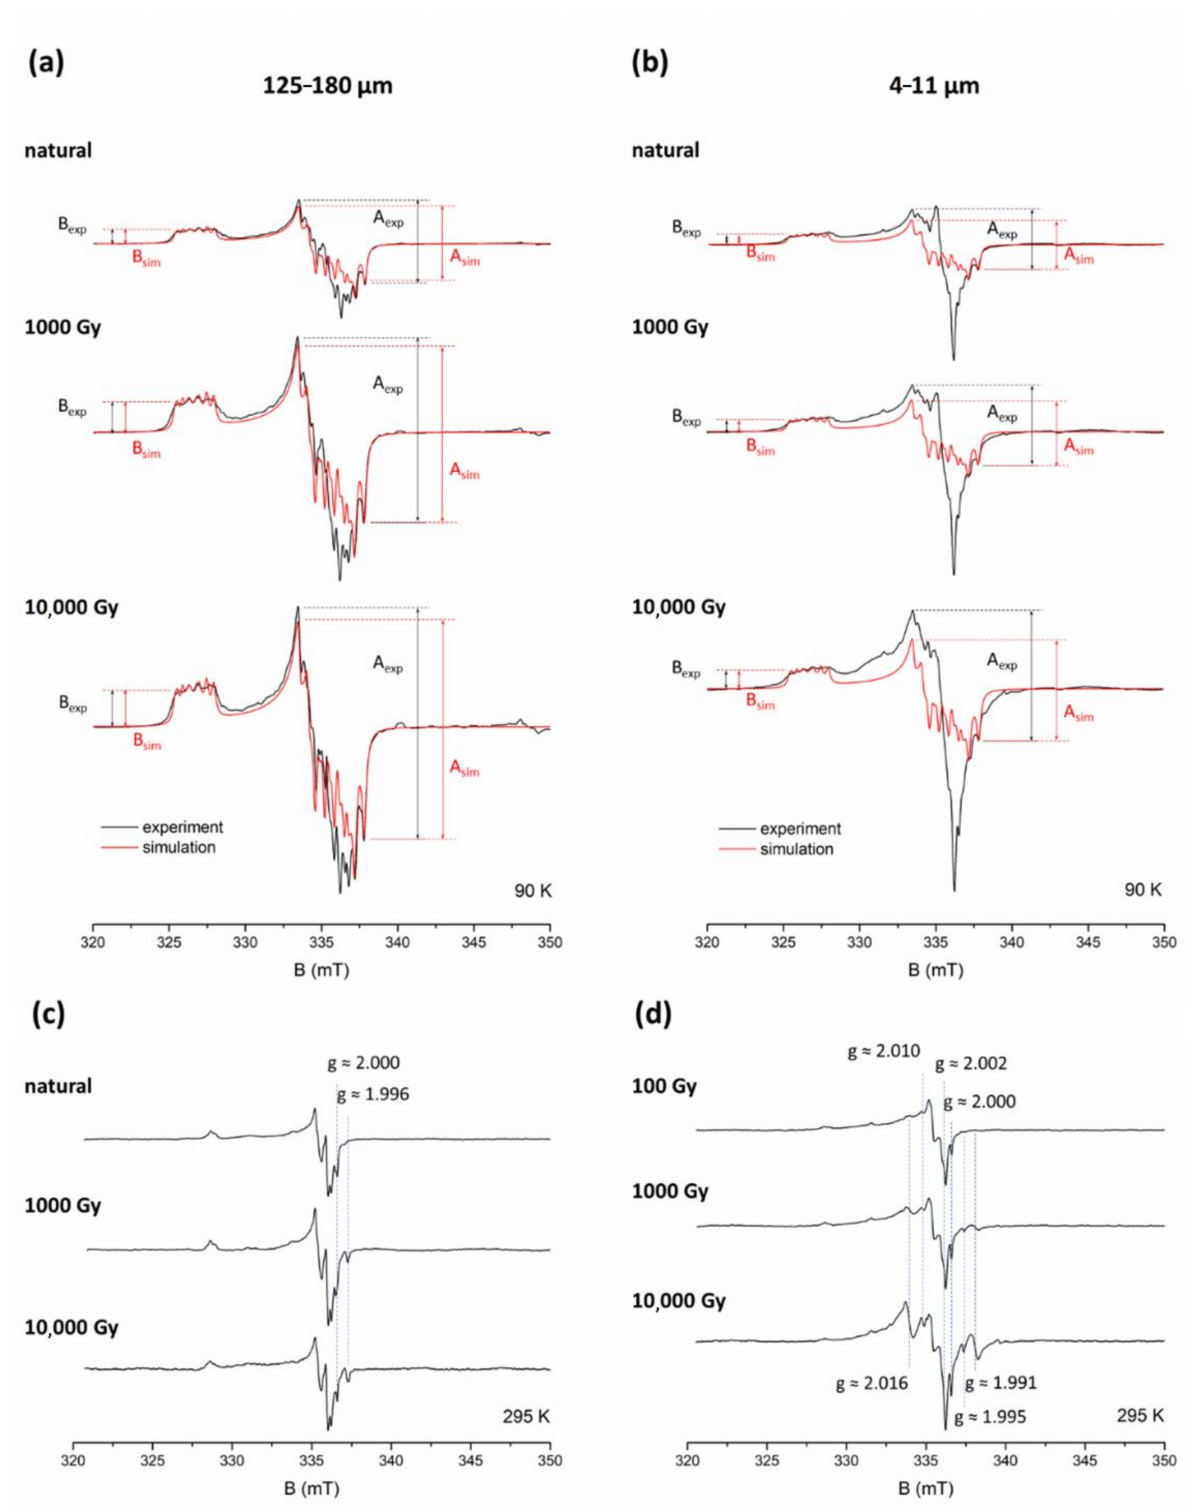
Figure 4. EPR spectra of the coarse (125–180 µ m) and fine (4–11 µ m) fraction of sample STY 1.10, natural and additionally irradiated with 1000 and 10,000 Gy, recorded at 90 K (( a , b ), respectively) and at room temperature (( c , d ), respectively), and simulated spectra of Al-h signal (in red). Amplitudes A exp , A sim , B exp and B sim are marked with arrows. Major dose-dependent signals observed at room temperature are marked with blue dashed lines. The 90 K spectra for coarse grains are multiplied by a factor of